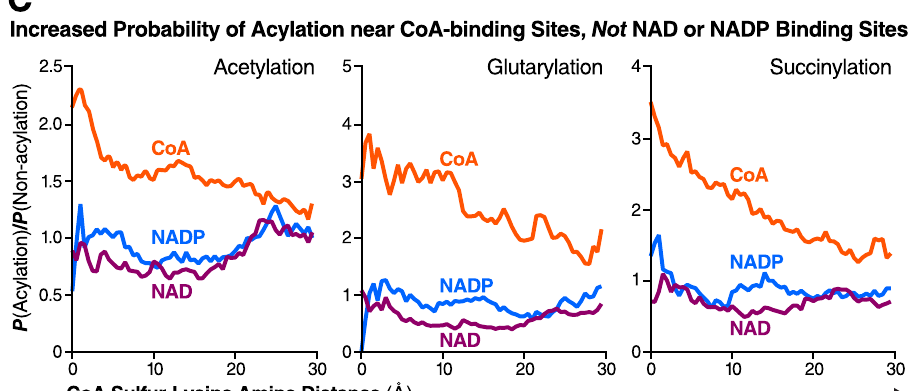
MS analysis results showed that acetylation at lysine residues near the CoA-binding pocket (K282, K284, and K204) in ECHS1 induced by acetyl-CoA incubation was inhibited by a 25-molar excess of CoA (Fig. 7). These results suggest that CoA more generally inhibits acyl-CoA-induced lysine acylation near CoA-binding pockets for multiple distinct acylation species.